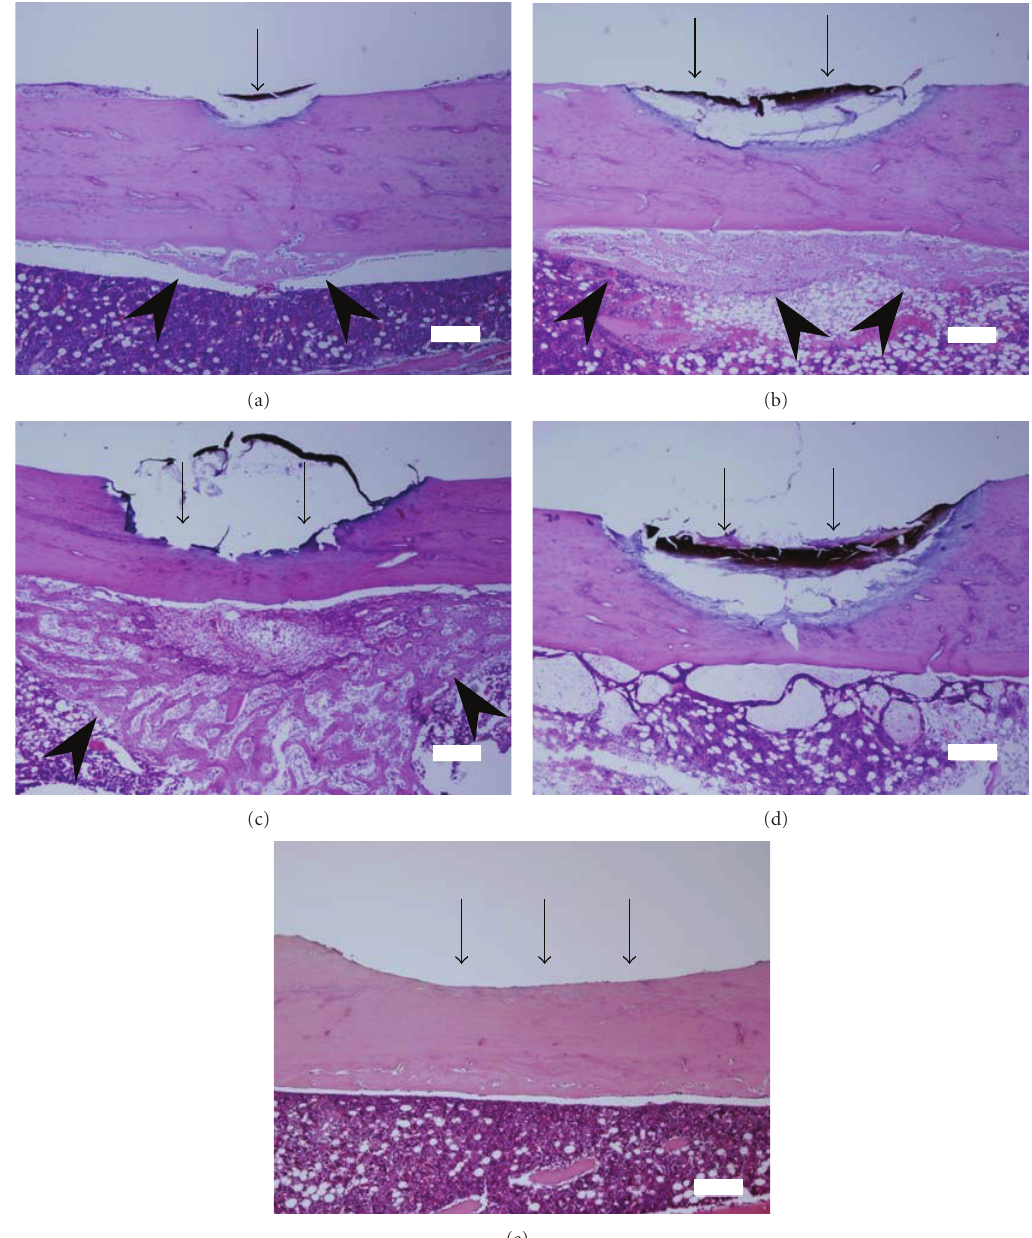
Figure 2: Comparison of osteoid formation in the bone marrow space in the laser-irradiated group and bur-injured group 5 days after treatment. (a) laser-irradiated tibia. Energy density = 88.2 J/cm 2 , (output: 1.0W, irradiation time: 2sec). (b) laser-irradiated tibia. Energy densities = 220.5 J/cm 2 , (output: 1.0 W, irradiation time: 5 sec). (c) laser-irradiated tibia. Energy densities = 441.0 J/cm 2 , (output: 1.0 W, irradiation time: 10sec). (d) laser-irradiated tibia. Energy densities = 661.5 J/cm 2 , (output: 1.0 W, irradiation time: 15sec). (e) bur-injured tibia. (a–d) laser-irradiated tibia showed an ablation defect, carbon deposits, and numerous empty osteocytic lacunae. Moreover, newly formed trabecular bone was observed on the marrow side of the laser-treated site (a–c). (e) bur-injured tibia showed a slight amount of reactive bone formation on the endosteal surface. H&E stain with 40x magnification. Bar = 200 µ m. Arrow indicates laser-irradiated or bur-injured site. Arrow heads indicate osteoid formation